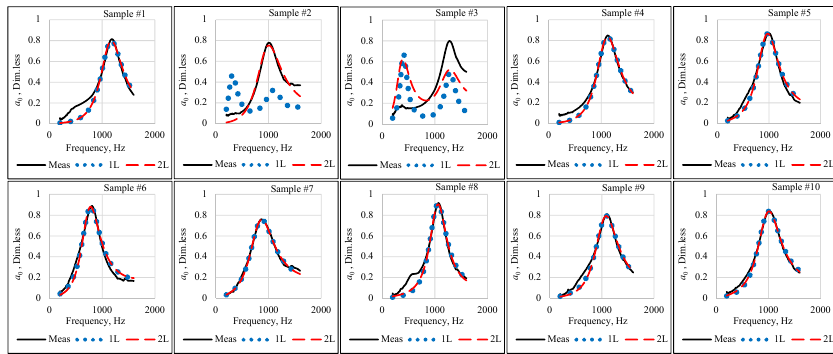
Figure 8. a 0 plots (optimization in 300–1600 Hz, estimated resistivity)